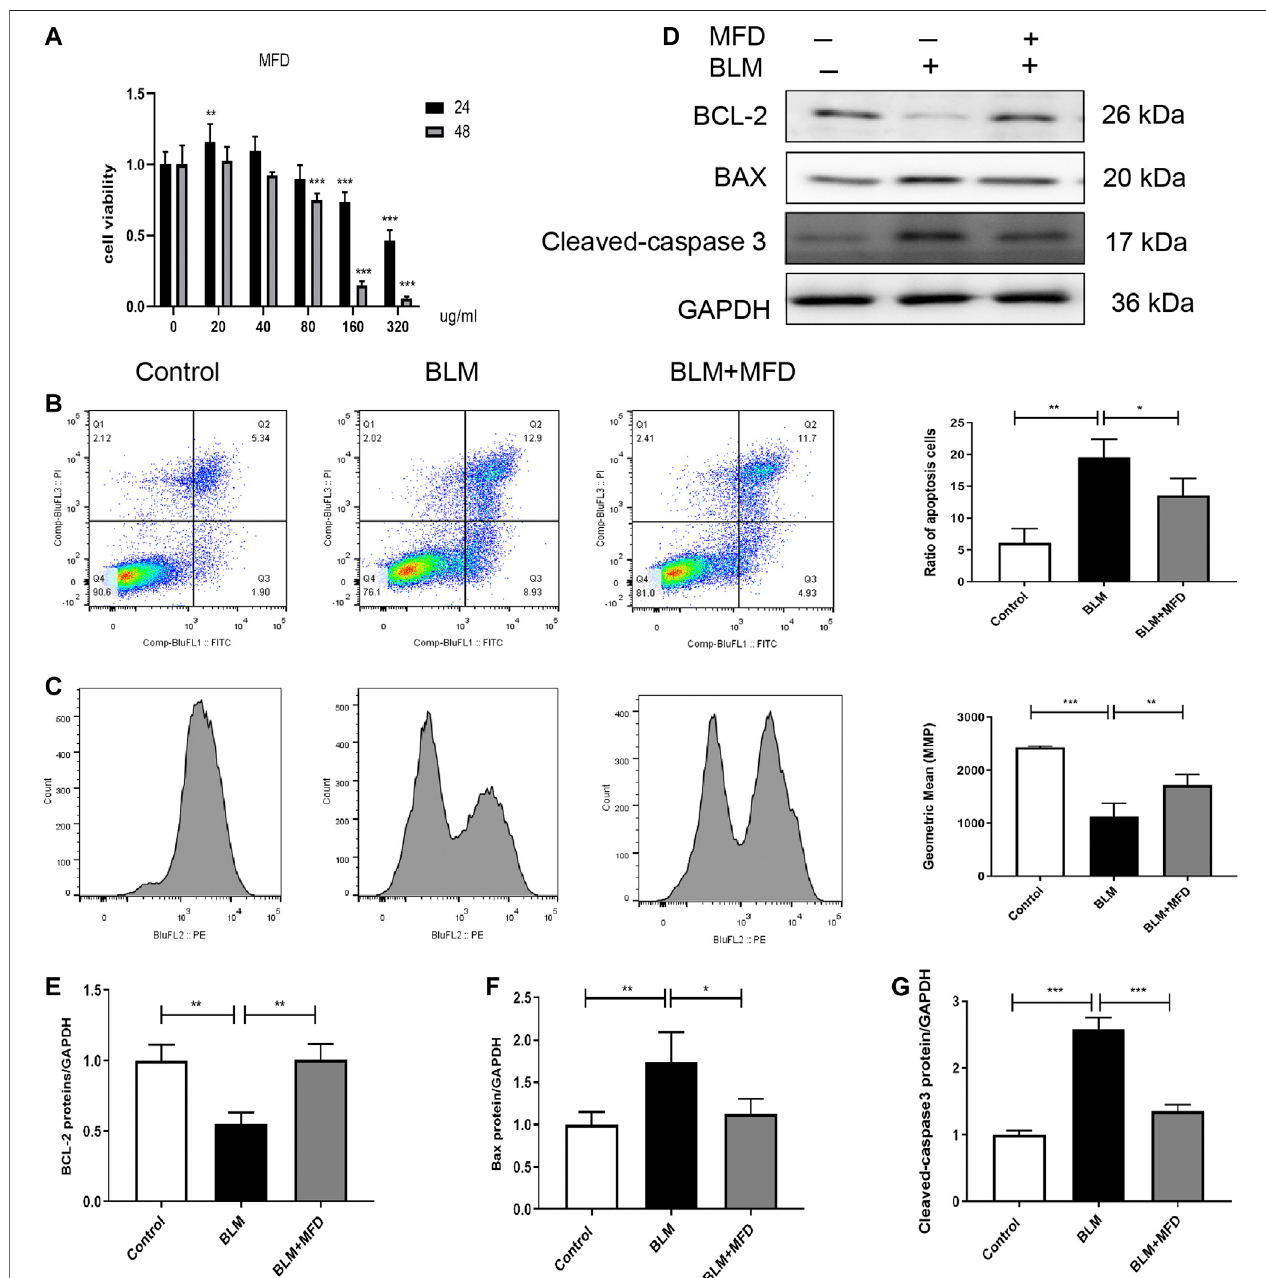
FIGURE 6 | Mefunidone abated belomycin-induced apoptosis of MLE-12 cells. (A) : The effect of different concentration and pretreatment duration of mefunidone onviabilityofMLE-12cellsdetectedbyCCK-8assay.MLE-12cellsweretreatedwithmefunidoneatconcentrationsof0,20,40,80,160and320 μ g/mlfor24 hor48 h. (B) : Flow cytometry of FITC/PI and quantitative comparison of MLE-12 cells treated with bleomycin (400 μ g/ml) or PBS with/without mefunidone (40 μ g/ml) pretreatment. (C) : Mitochondrial membrane potential and quantitative comparison of MLE-12 cells treated with bleomycin (400 μ g/ml) or PBS with/without mefunidone (40 μ g/ml) pretreatment (D – G) : Western blotting (D) and quantitative analysis of Bcl-2 (E) , Bax (F) , and Cleaved-caspase 3 (G) in MLE-12 cells treated with bleomycin (400 μ g/ml)with/withoutMFD(40 μ g/ml)pretreatment. All experiments wereconductedwithmore thanthree independentreplications.Datawerepresented as mean ± SD. ANOVA was used for comparison used in (B,C, and E – G) . * p < 0.05; ** p < 0.01; *** p < 0.001.